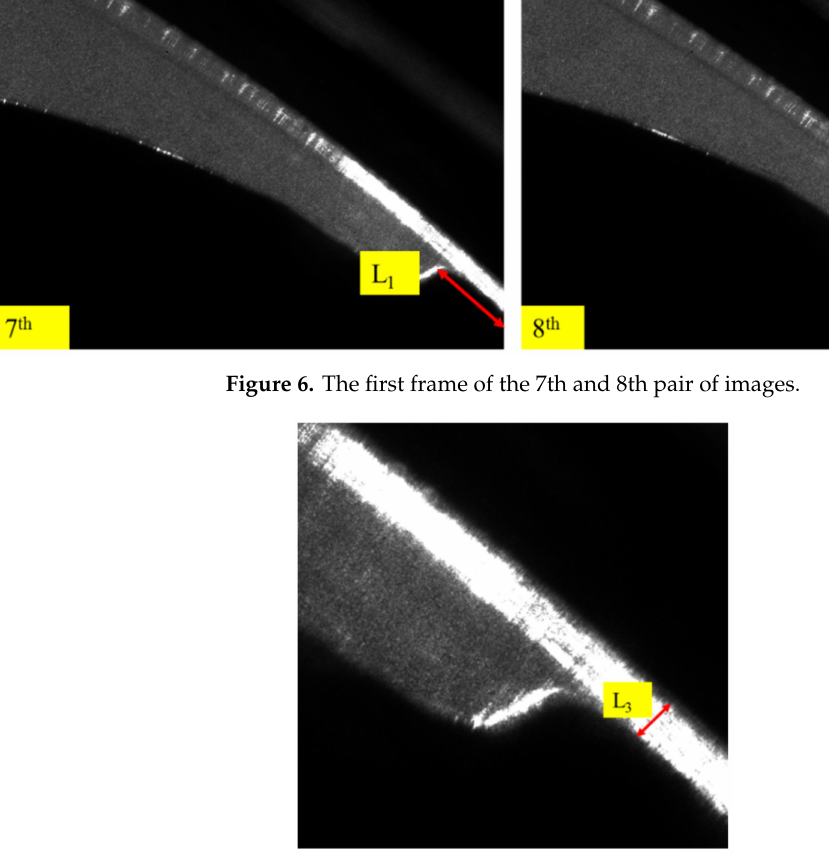
Figure 7. The measurement of the tip gap